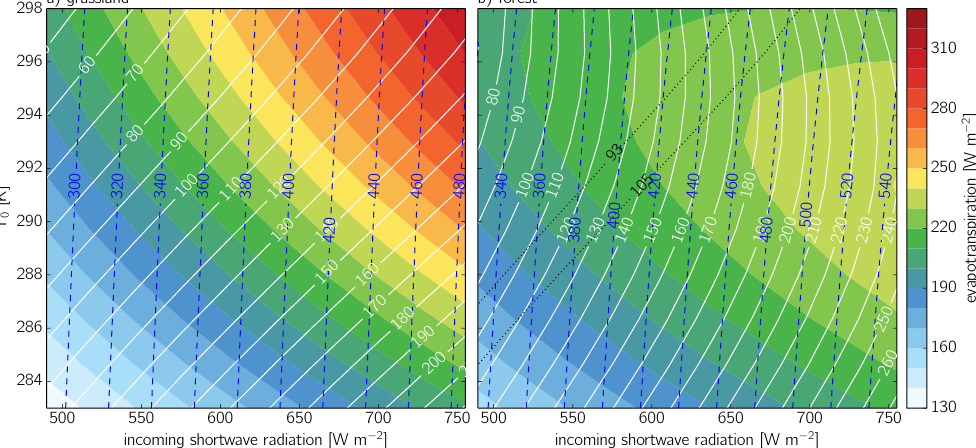
Figure 4. Evapotranspiration or latent heat flux (color band), sensible heat flux (white solid lines) and net radiation (blue dashed lines). The values are the 10h means over the entire duration of the model run. The black dotted lines correspond to the range in which grassland gives a constant sensible heat flux with similar magnitudes as those in the observations in Fig. 1.